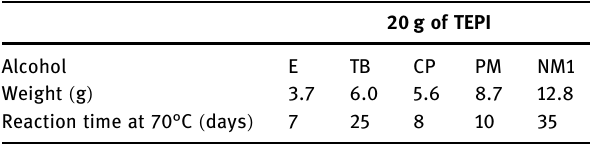
Table 1: Reaction